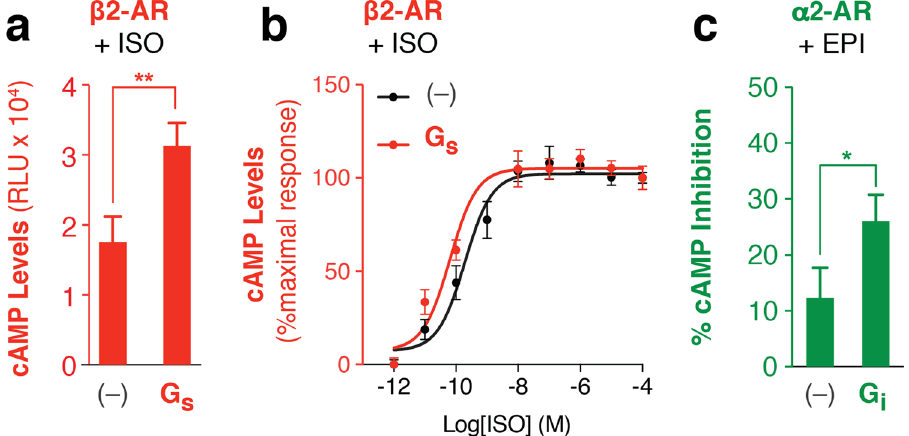
Figure 2. Agonist enhances downstream second messenger response via the fused G protein. ( a ) cAMP production in the presence of ( a ) saturating (100 μ M) or ( b ) varying concentration of isoproterenol for β 2-AR tethered with or without (–) Gs. ( b ) Data are represented as percent maximum cAMP levels for 100 μ M isoproterenol treatment of β 2-AR fusions tethered with or without (–) Gs. ( c ) Percent inhibition of 1 μ M forskolin induced cAMP production for α 2-AR fusions with or without Gi treated with 100 μ M epinephrine. Data are derived from at least three independent experiments, with at least three replicates per condition (mean ± S.E.M. Student’s t-test was performed to evaluate significance * p ≤ 0 . 05 ; ** p ≤ 0 . 01